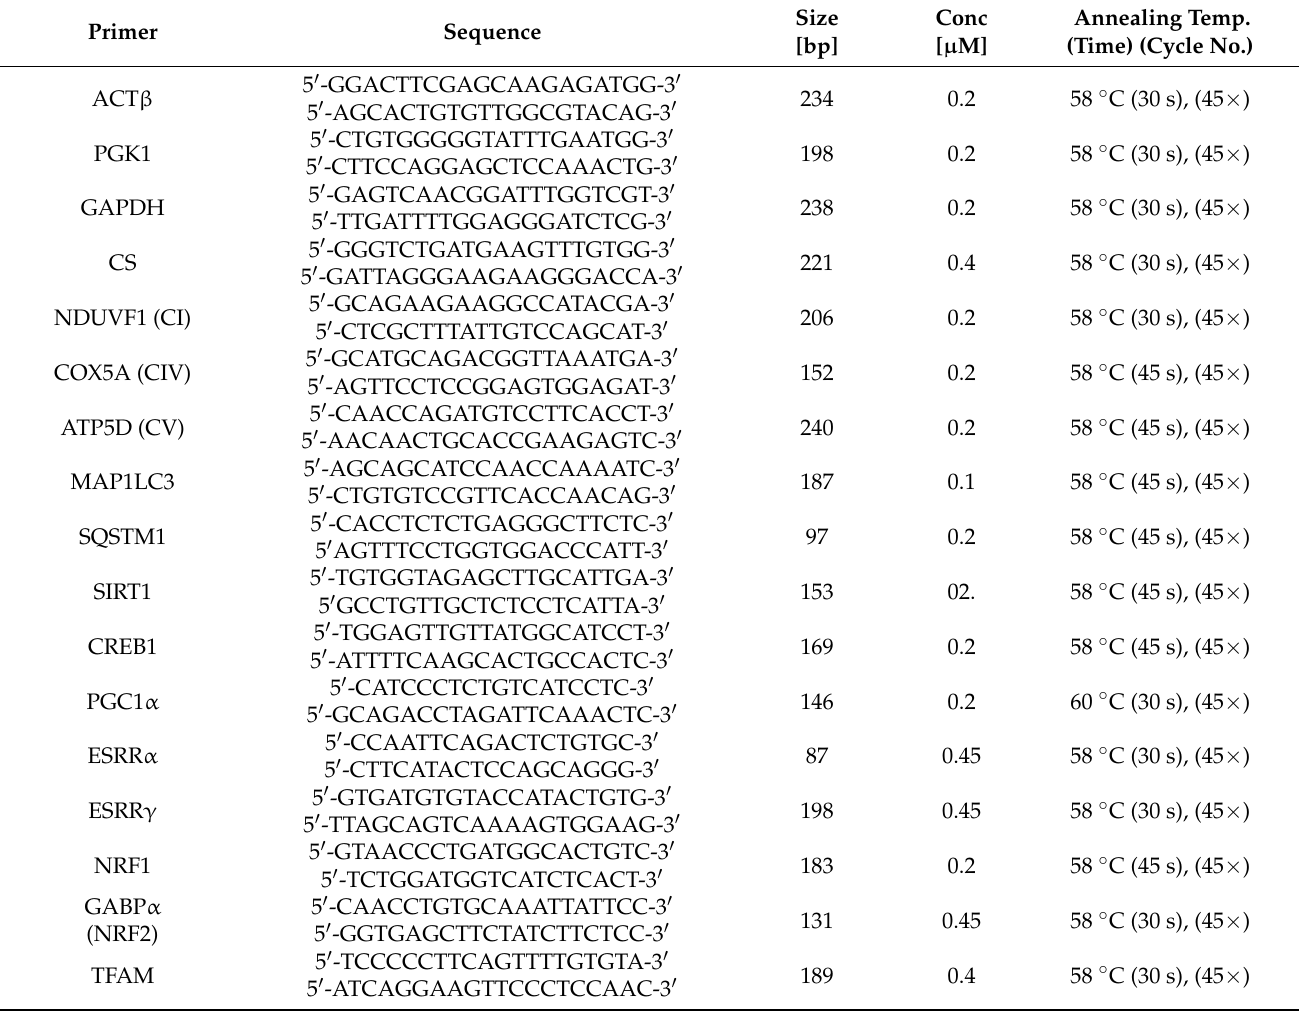
Table 2. Primer sequences, manufacturer’s, product sizes, concentrations and program used for qRT-PCR measurement. ACT β , PGK1, and GAPDH were used as housekeeping